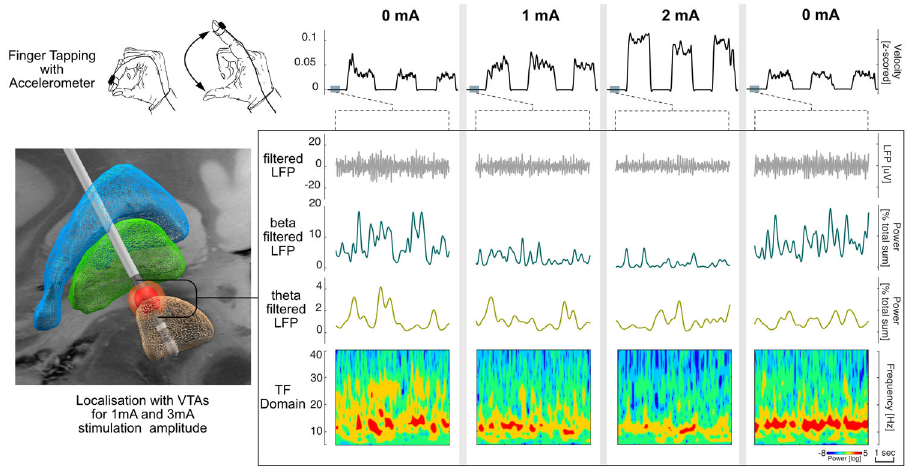
Fig. 2 Beta frequency band suppression during stimulation corresponds to bradykinesia improvement. Representative example of analyzed data per stimulation level. Columns represent steps of increasing stimulation amplitude: stimOFF – 1 mA stimON – 2 mA stimON – stimOFF. Upper trace shows smoothed velocity traces of fi nger tapping. Resting state LFP-recordings from contact pair 1 – 3 are shown as (i) fi ltered LFP (5 – 48/52 – 98 Hz), (ii) beta fi ltered LFP (13 – 35 Hz), (iii) theta band fi ltered LFP (5 – 8 Hz) as control frequency, and iv) time- frequency representation; left: DBS localization and VTA reconstruction for 1 and 2 mA, visualized as previously described 57 .